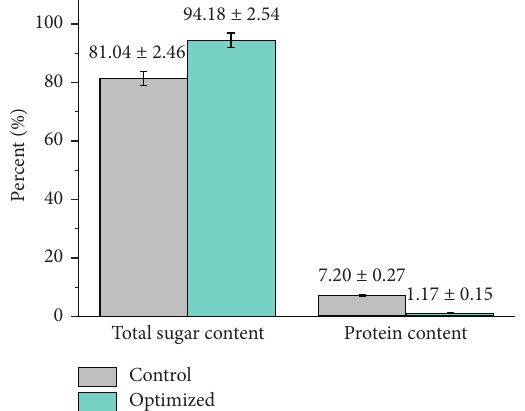
Figure 6: The change of total sugar content and protein content.